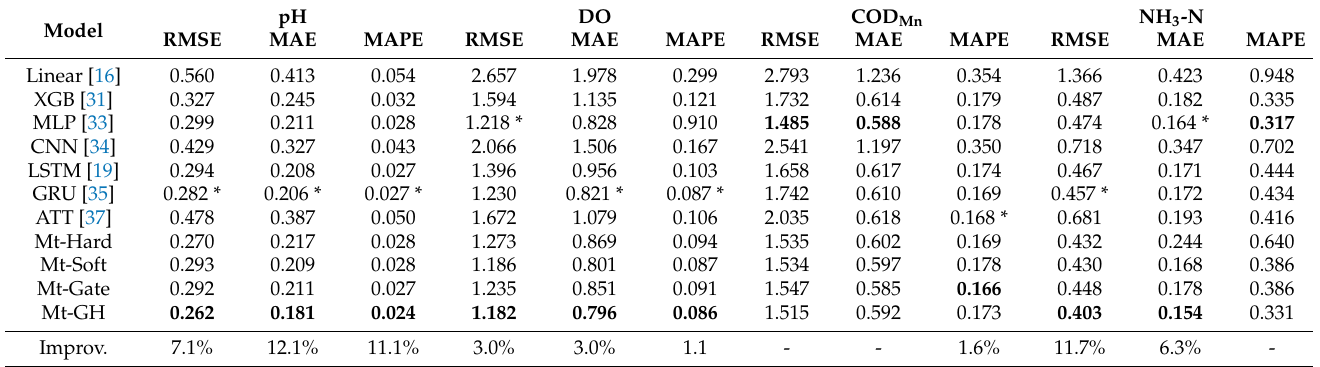
* In the table, the bold numbers are the best, and the numbers with asterisk are the second